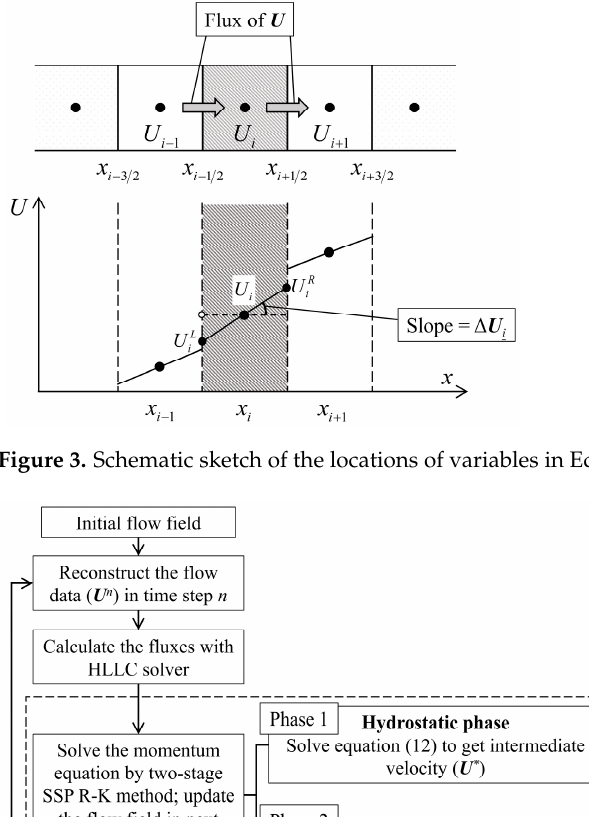
Figure 2. Keller-Box layout of computational variables. Velocities ( u , v , w ), water depth ( h ), and passive tracer scaler ( C ) are all placed at cell center and dynamic pressure ( p ) is placed at vertical cell face.